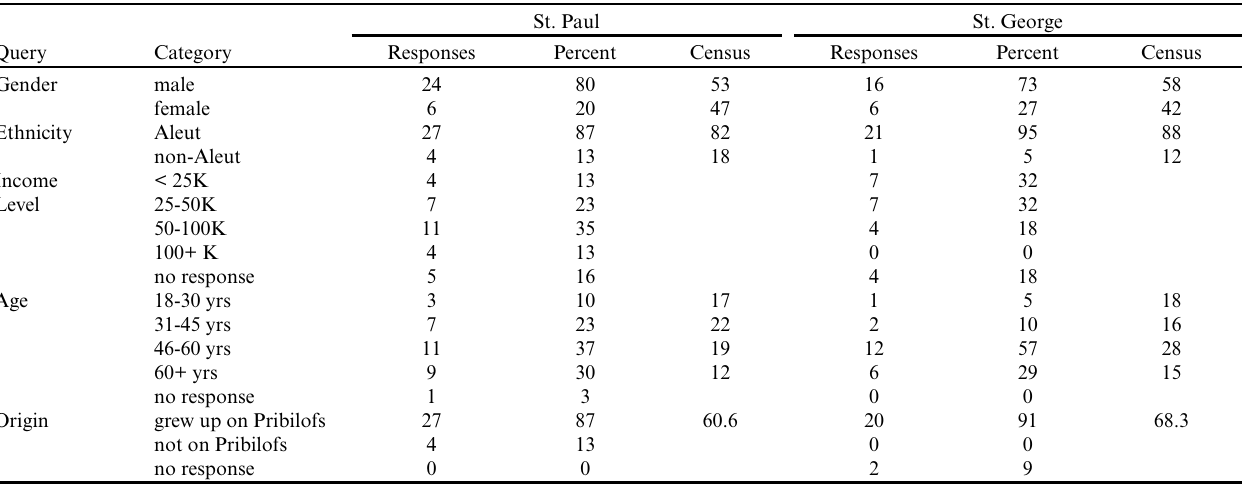
Table 1 . Demographic parameters. Census numbers are from the 2010 federal census, archived by the Alaska Department of Commerce, Community, and Economic Development at http://commerce.alaska.gov/cra/DCRAExternal/community, except for the “grew up on the Pribilofs” category, where they are from a 1994 Alaska Department of Fish and Game subsistence survey of households. Note, the 2010 census numbers reflect the entire population, whereas our numbers reflect only heads of households responding to our survey. The differences in whole population versus heads of households are particularly noticeable in age and gender categories.